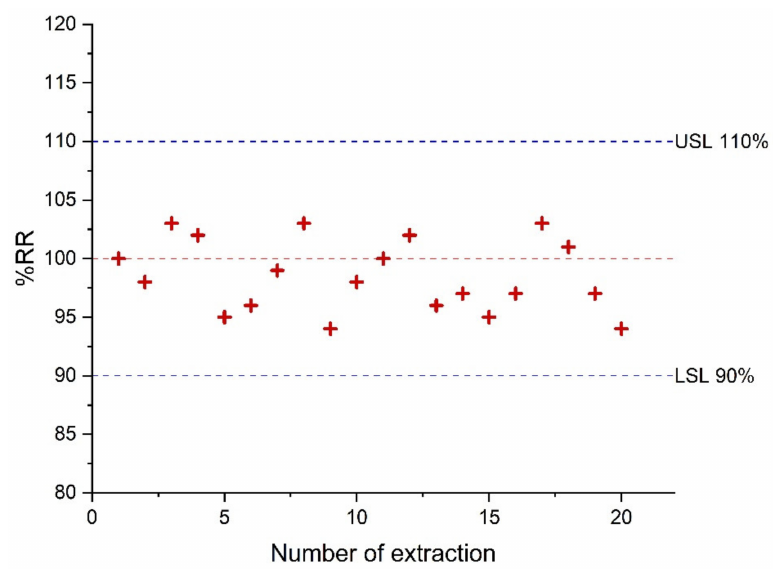
Figure 4. Reusability of PDMDPheS-coated FPSE membrane. (red crosses indicate the results of each measurement).